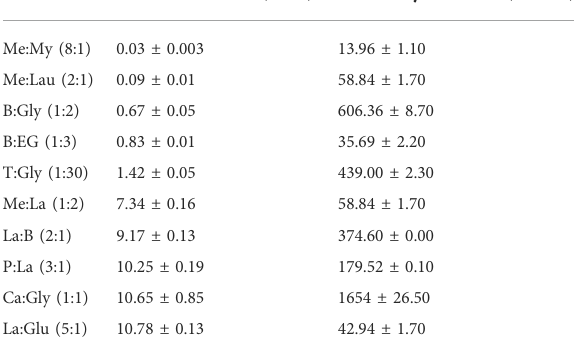
TABLE 2 Water content and viscosity of the selected and previously prepared NADESs. NADES Water content (wt%) Viscosity at 40 ° C (mPa.s)